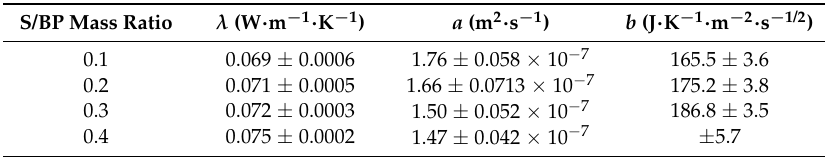
Table 2. Thermal properties of S-BP composites at 23 ◦